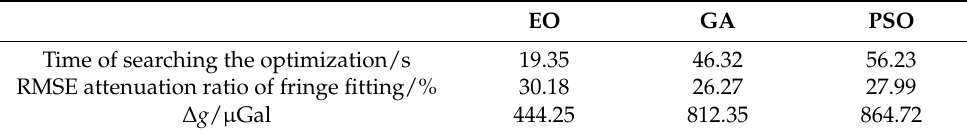
Table 2. Comparison of the algorithms with single vibration compensation.